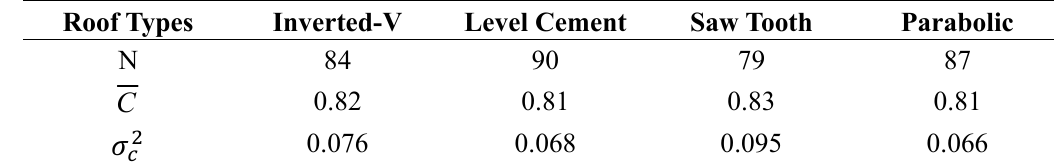
Table 2. Variation of C value for four types of